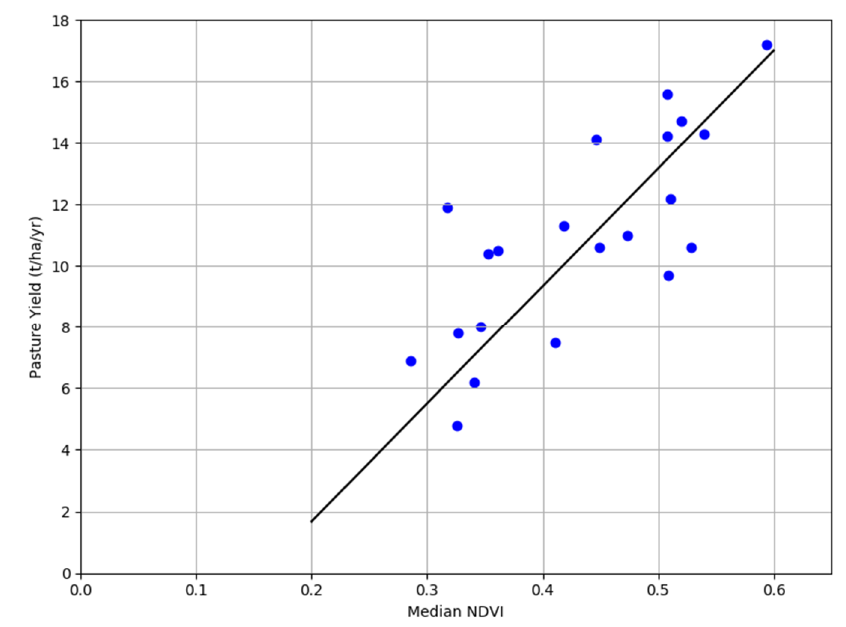
Figure 4. A relationship between average annual pasture yield and observed median NDVI, with the developed model shown in